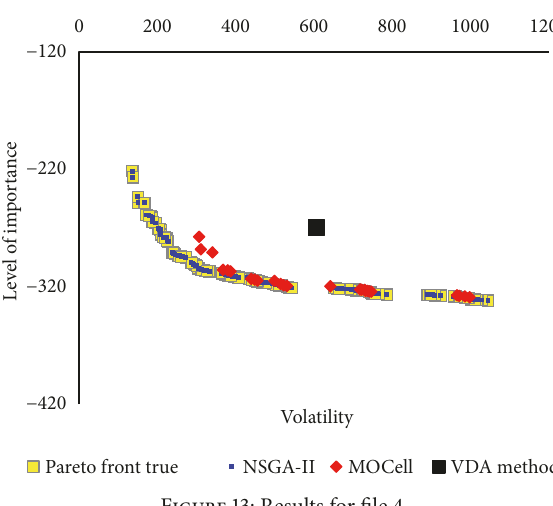
Figure 11: Results for file 2.